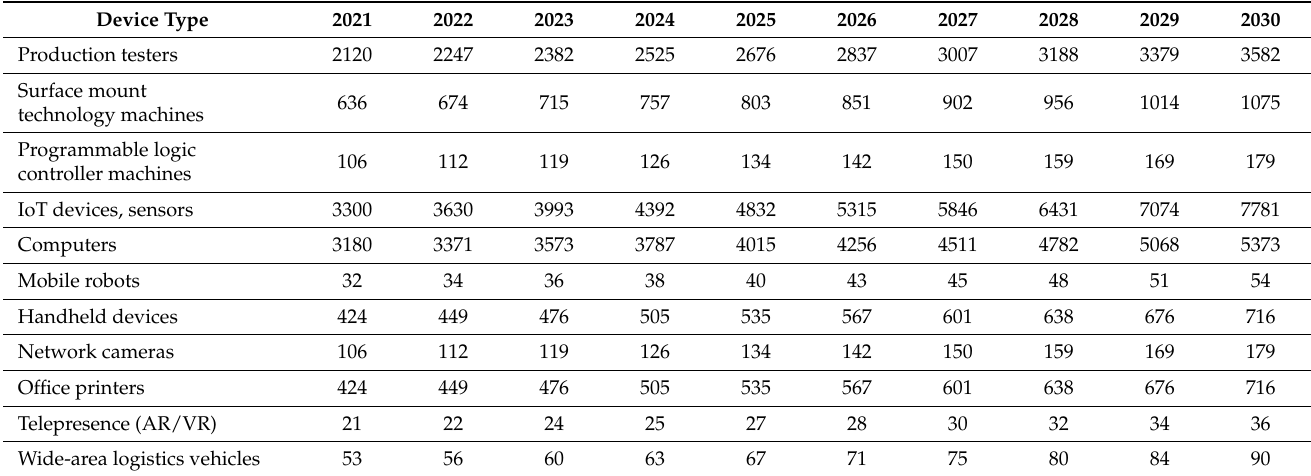
Table 3. Devices forecast (2021–2030) for ten factories with a 6% CAGR (with 10% CAGR for IoT devices). Device